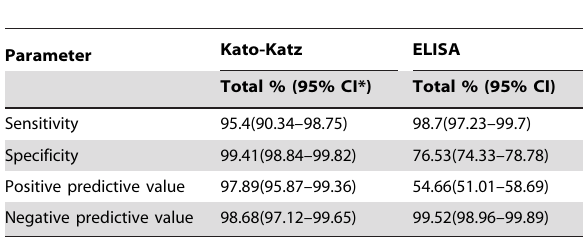
Table 3. Test properties of the Kato-Katz methods and ELISA as estimated by Bayesian